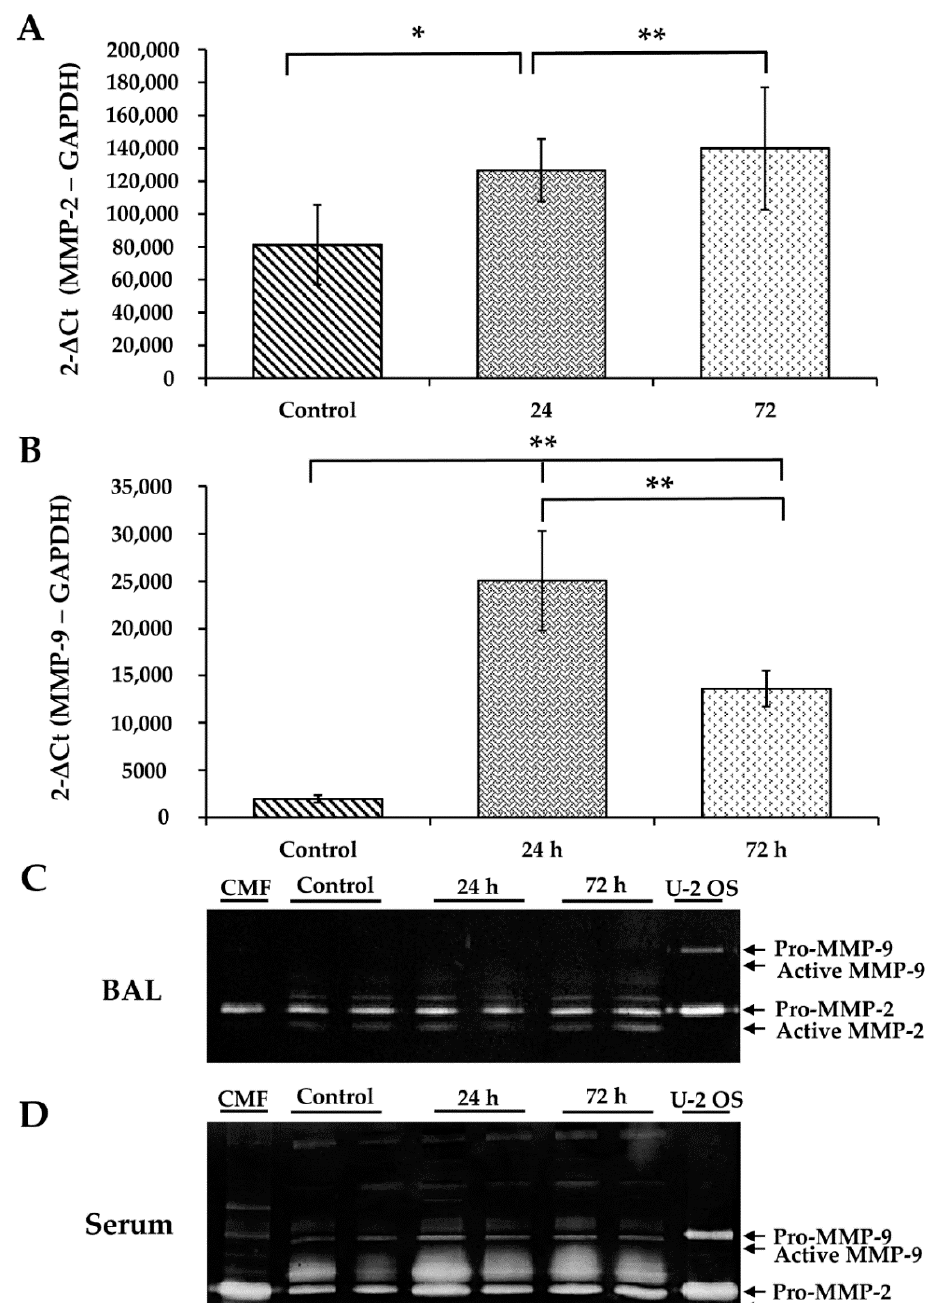
Figure 4. The effect of WS on MMP-2 and MMP-9 mRNA expression in lung and gelatinolytic activity in BAL and serum. Expression of MMP-2 ( A ) and MMP-9 ( B ) mRNAs in lung and gelatinolytic activity in BAL ( C ) and serum ( D ). qRT-PCR detected the mRNA levels of MMP-2 and MMP-9. Gelatinolytic zymography detected the gelatin activity of MMP-2 and MMP-9 in BAL and serum of WS treated guinea pigs ( n = 8). * p < 0.05, ** p < 0.01 compared with the control.